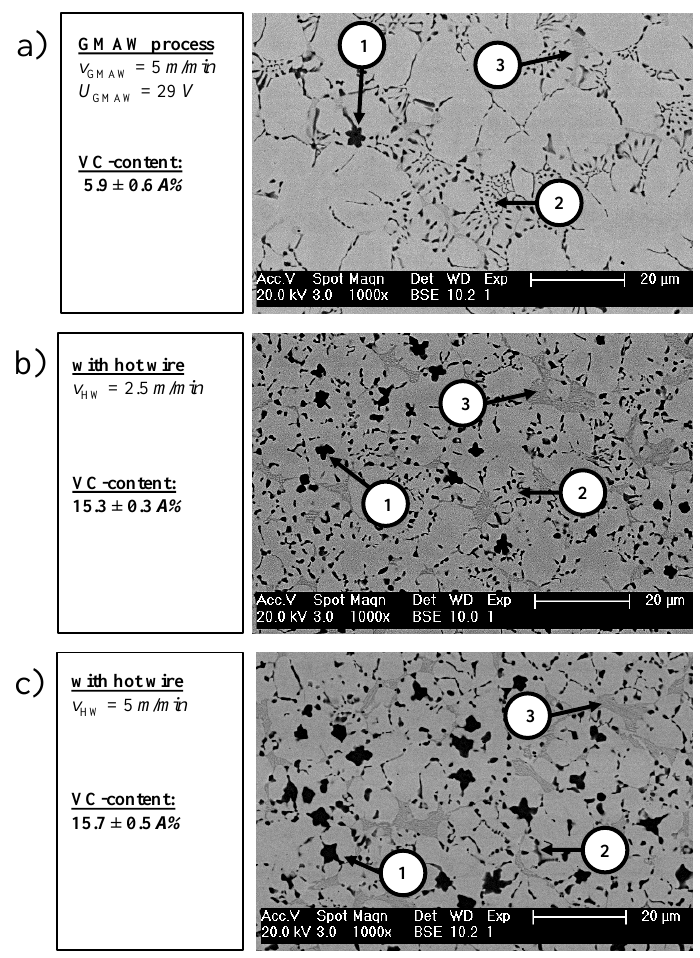
Figure 8. Influence of an additional hot wire on the microstructural properties; primary vanadium carbides (VCs) (1), eutectic VCs (2), and eutectic Cr-rich carbides (3). ( a ) Microstructure of conventional GMAW ( v GMAW = 5 m/min) with a primary VC-content of 5.9 A%, ( b ) by applying an additional hot wire ( v HW = 2,5 m / min), the amount of primary VCs increased to 15.3 A%, ( c ) by applying an additional hot wire ( v HW = 5 m / min), the amount of primary VCs increased to 15.7 A%.